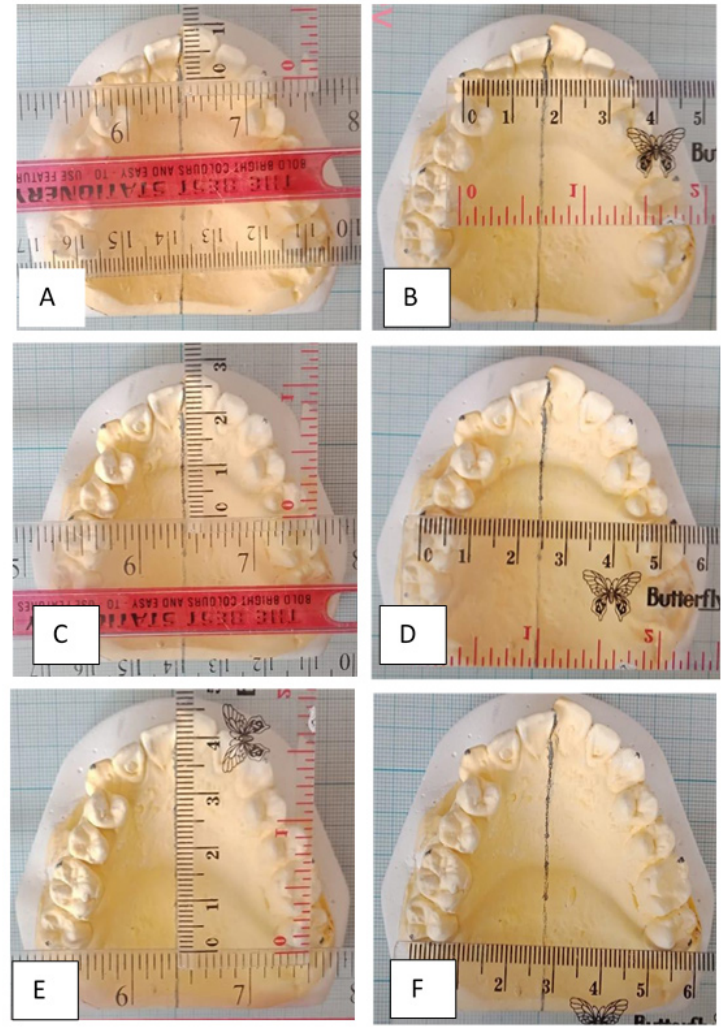
Figure 4. Measurement of upper dental arch form. The sagittal dental arch from the arrow of the anterior curve (L31) ( A ); from right canine cusp to left canine cusp is identified as intercanine width (L33) ( B ); the incisal edge to the line joining the mesiobuccal canines of the first molar (L61) ( C ); the dental arch dimension from right first molar cusp to the left first molar cusp is intermolar width (L66) ( D ); the incisal edge to the line joining the distobuccal cusp of the second molar (L71) ( E ); from right second molar cusp to the left second molar cusp is the posterior intermolar width (L77) ( F